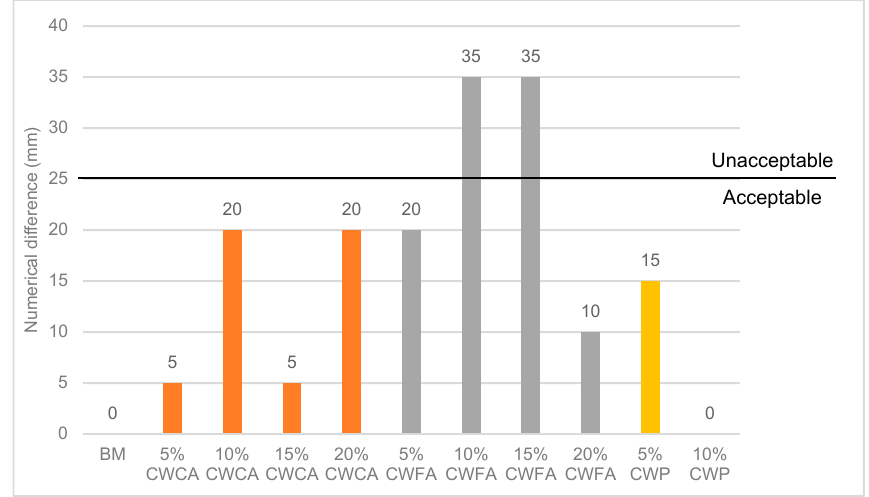
Figure 4. Numerical difference of the J-Ring flow and slump flow for SCC samples containing varying doses of CWCA, CWFA, and CWP.